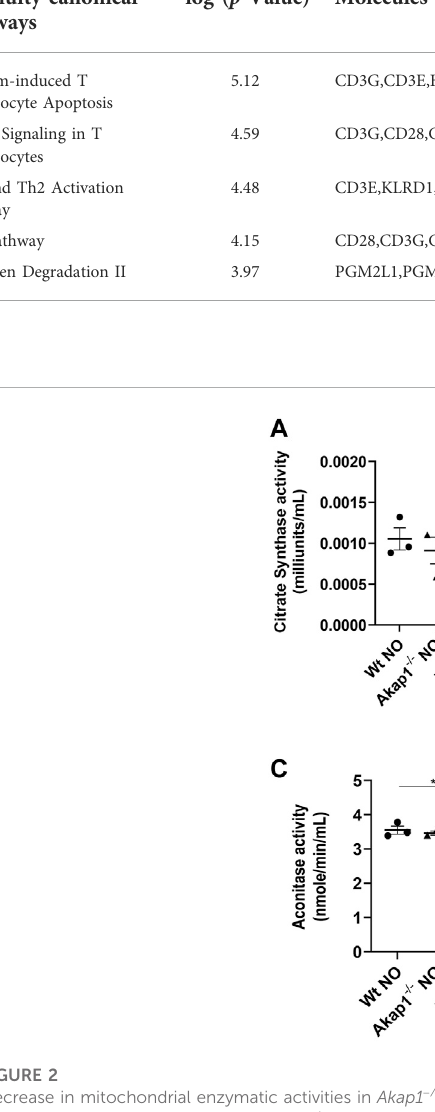
fumarase activity did not change in the Wt normoxia versus Wt hyperoxia control (Figure 2C, *** p < 0.001 versus Wt